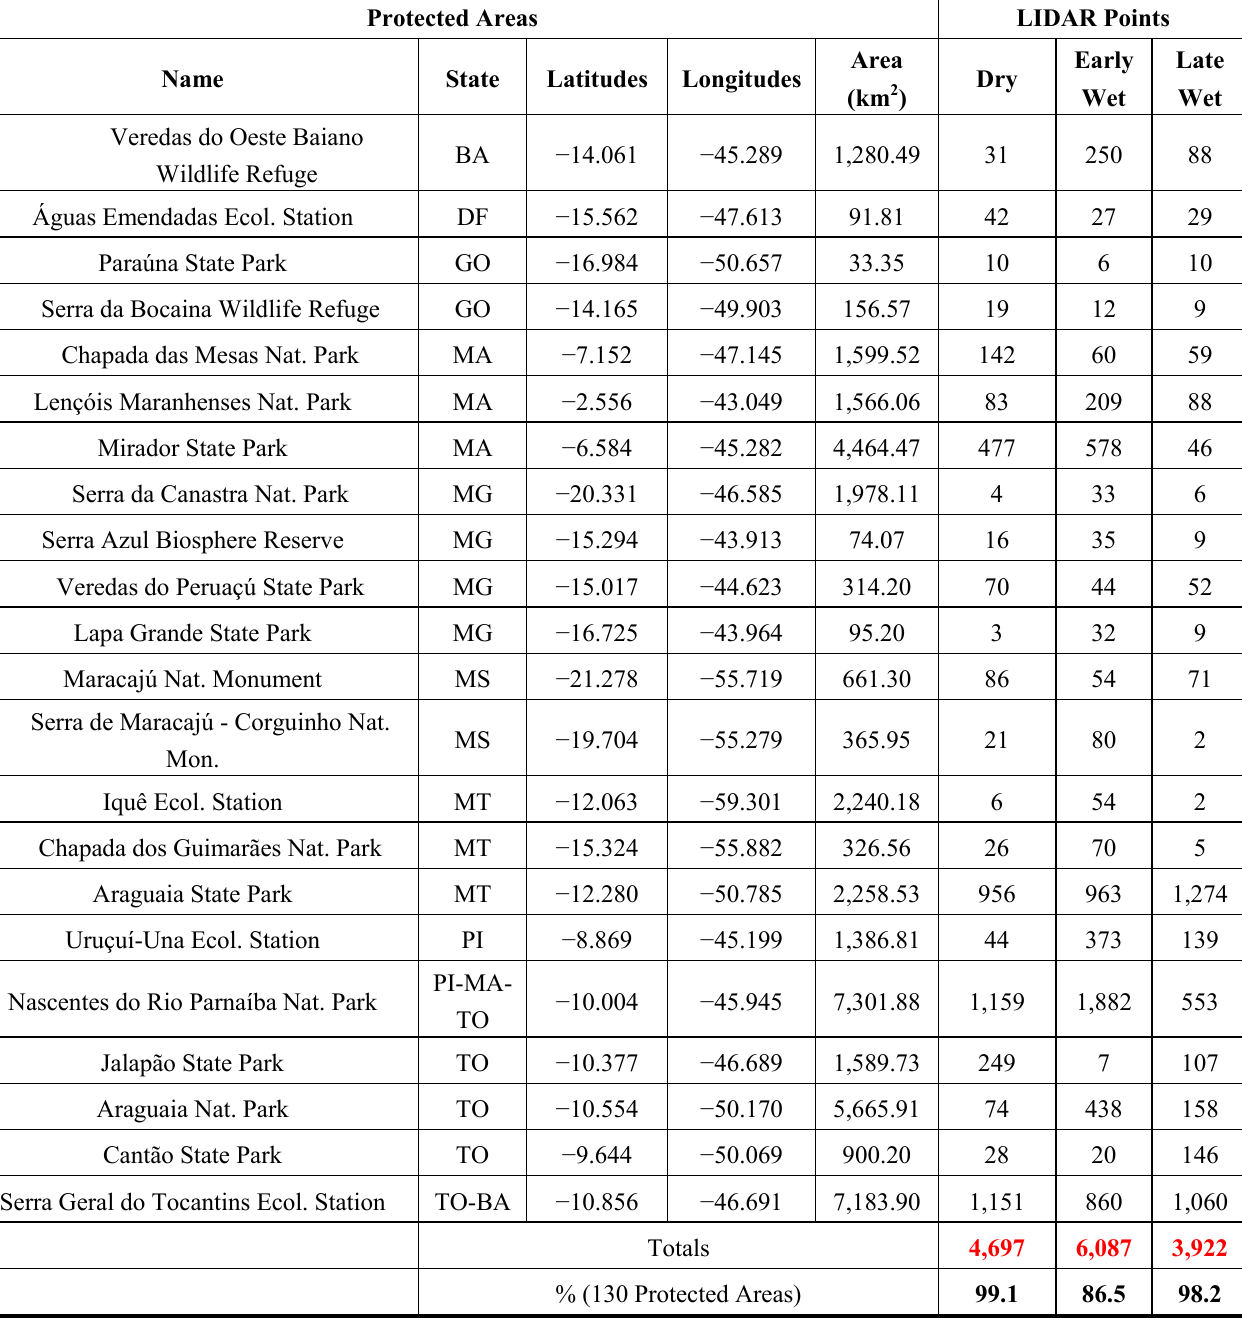
Table 4. 22 fully-protected Cerrado conservation units with coincident LIDAR occurrences from all major Cerrado seasonal periods (the inset figure details the LIDAR points from the dry season, early wet season, and late wet season over the Serra da Bocaina wildlife